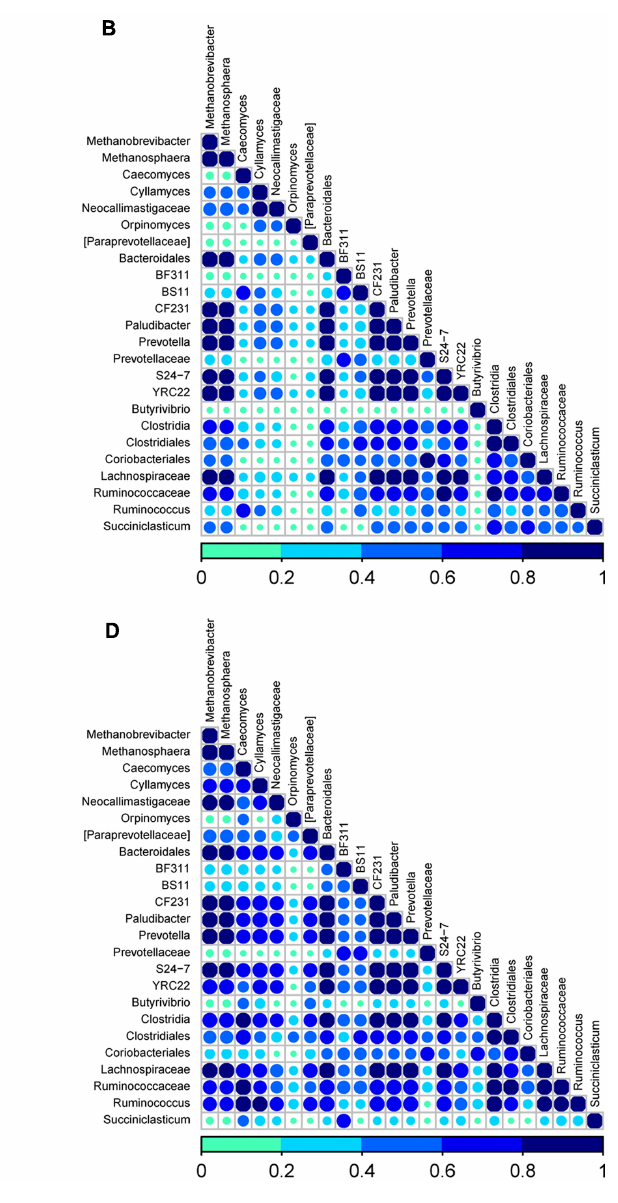
proportion = 0.001 are shown as a heatmap. Co-occurrence is shown by the color code (navy blue: high co-occurrence, sky blue: moderate co-occurrence; green: low co-occurrence) at the bottom. Sample identifiers are same as used in Figure 1